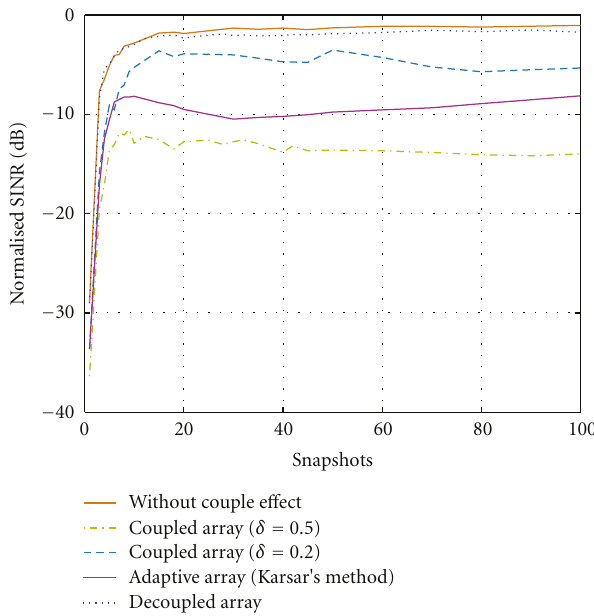
Figure 2: Normalized SINR in the array output before and after decoupling (URA 3 × 3). Table 4: C/No results with/without proposed method. Without proposed PRN